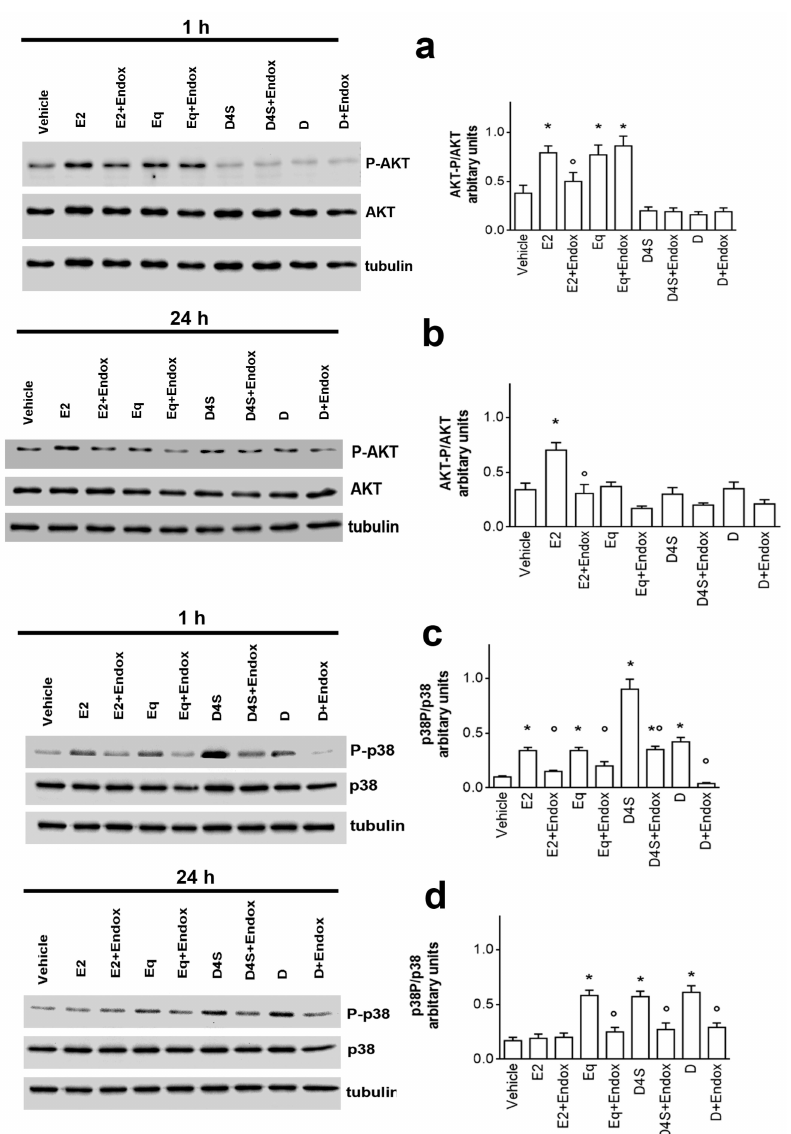
Figure 4. Daidzein, daidzein-4 (cid:48) -sulfate and equol action mechanism. The phosphorylation of the Ser473 residue of AKT (pAKT) ( a , b ) and Thr180 / Tyr182 residues on P-38 ( c , d ) was determined by western blot analysis in MCF-7 cells exposed for 1 h ( a , c ) and 24 h ( b , d ) to either vehicle (DMSO) or E2 (10 nM) in presence or absence of D, D4S and Eq (1 µ M). The nitrocellulose was stripped and then and then probed with anti-AKT or anti-P38 antibodies. In the panels, the pAKT / AKT ( a , b ) and pP38 / P38 ( c , d ) ratios are represented. These ratios are calculated with respect to tubulin obtained by densitometric analyses of three di ff erent experiments (mean ± SD). p < 0.001 was determined by Student t-test with respect to vehicle (*) or Endox-untreated ( ◦ ) samples. AKT: protein kinase B; E2: estradiol; Endox: endoxifen; ER α : estrogen receptor α ; NGB: neuroglobin; p38: p38 mitogen-activated protein kinase; D: daidzein; D4S: daidzein-4 (cid:48) -sulfate; Eq: